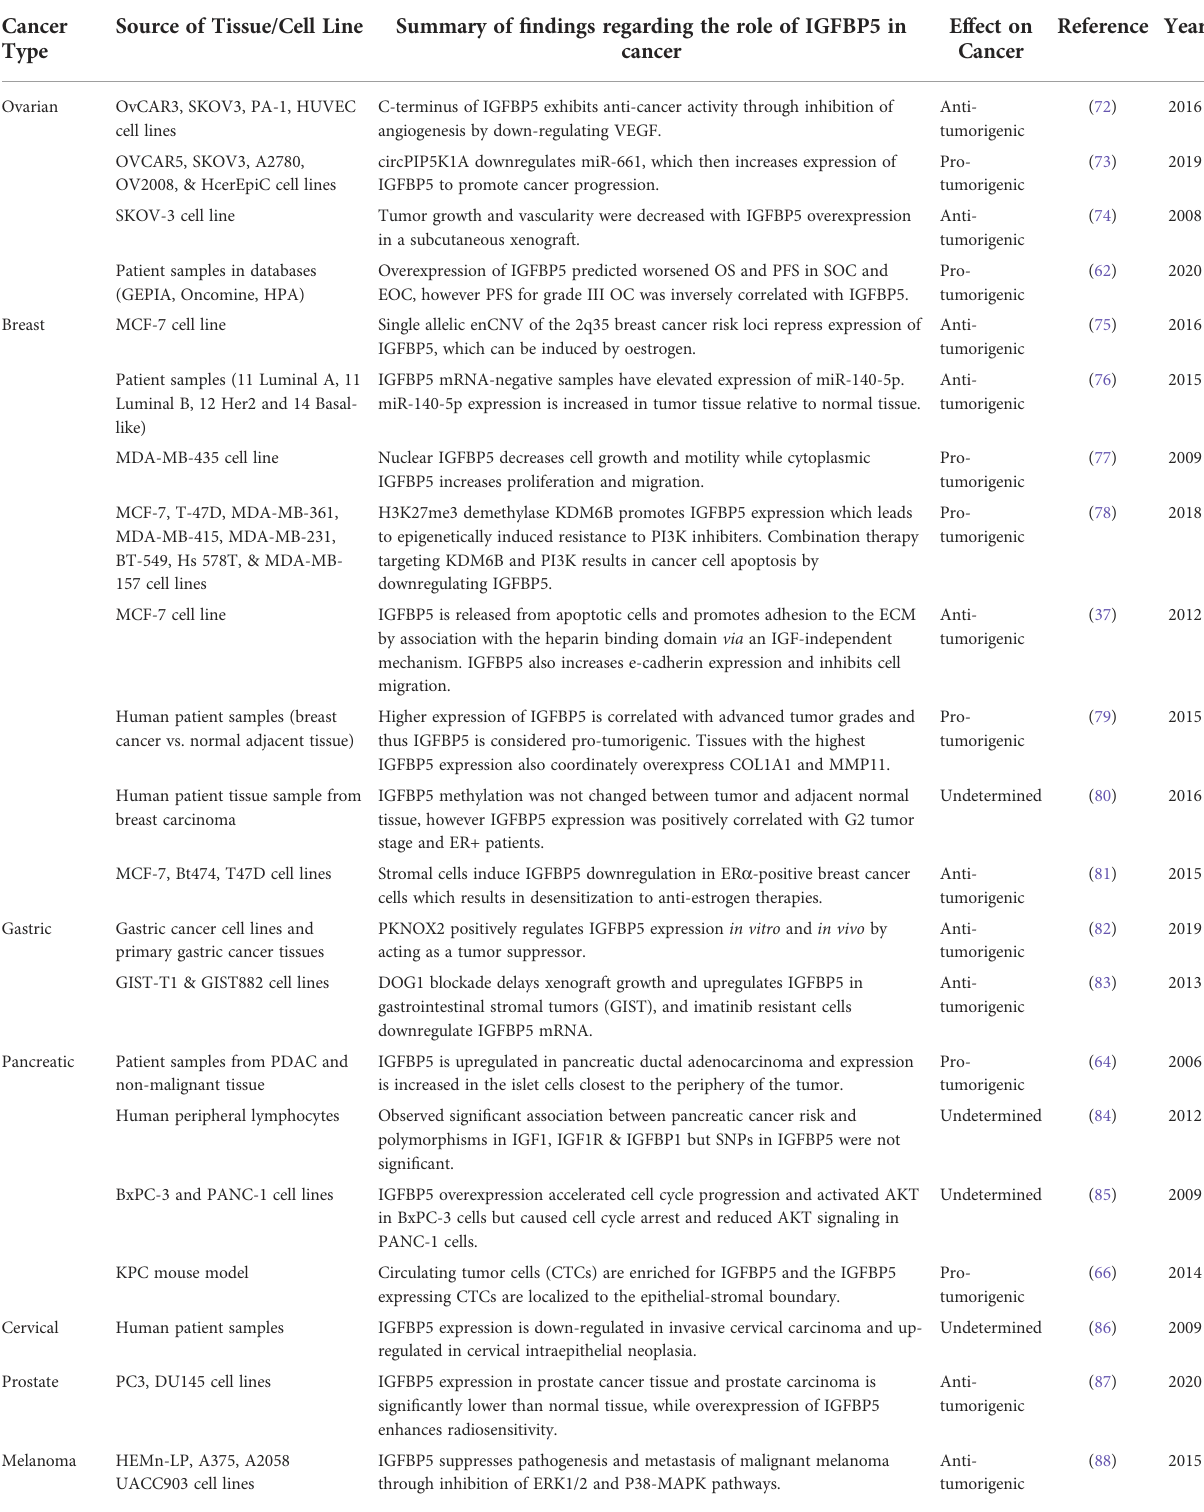
TABLE 1 Evidence for anti-tumorigenic, pro-tumorigenic, or undetermined functions of IGFBP5 in cancer. Cancer Type